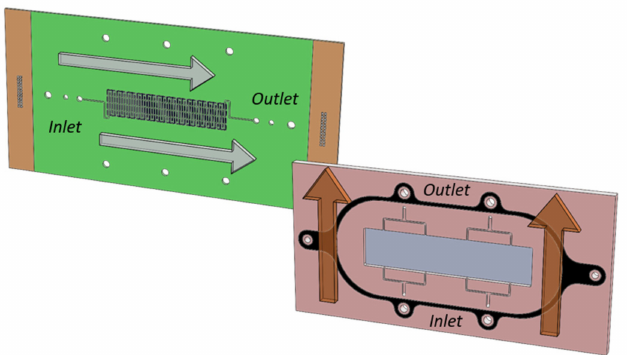
Figure 1. Electrolyte flow direction for anode ( left ) and cathode ( right